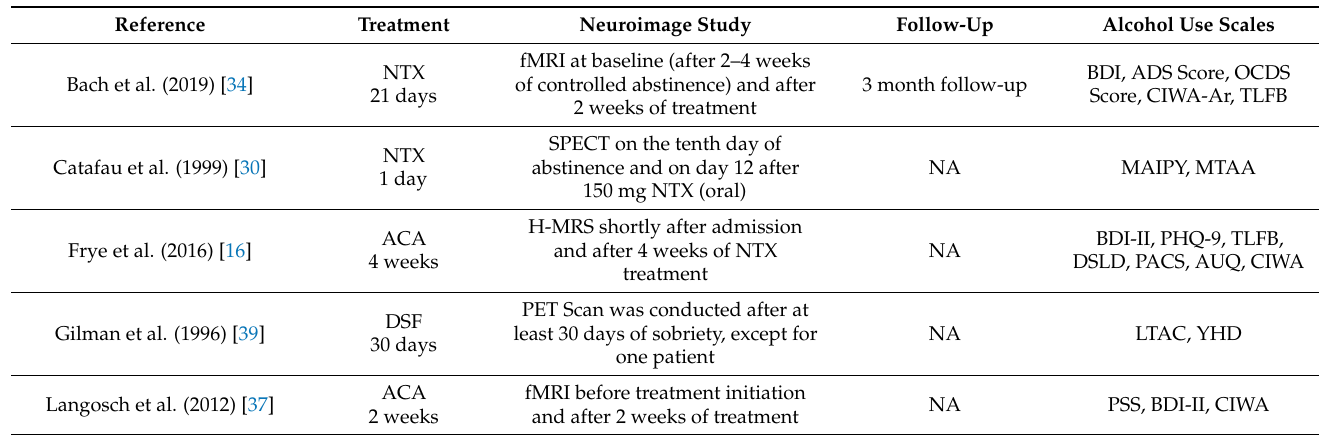
Table 2. Treatment characteristics of each study, including duration, neuroimage exam utilized, follow-up, and measures